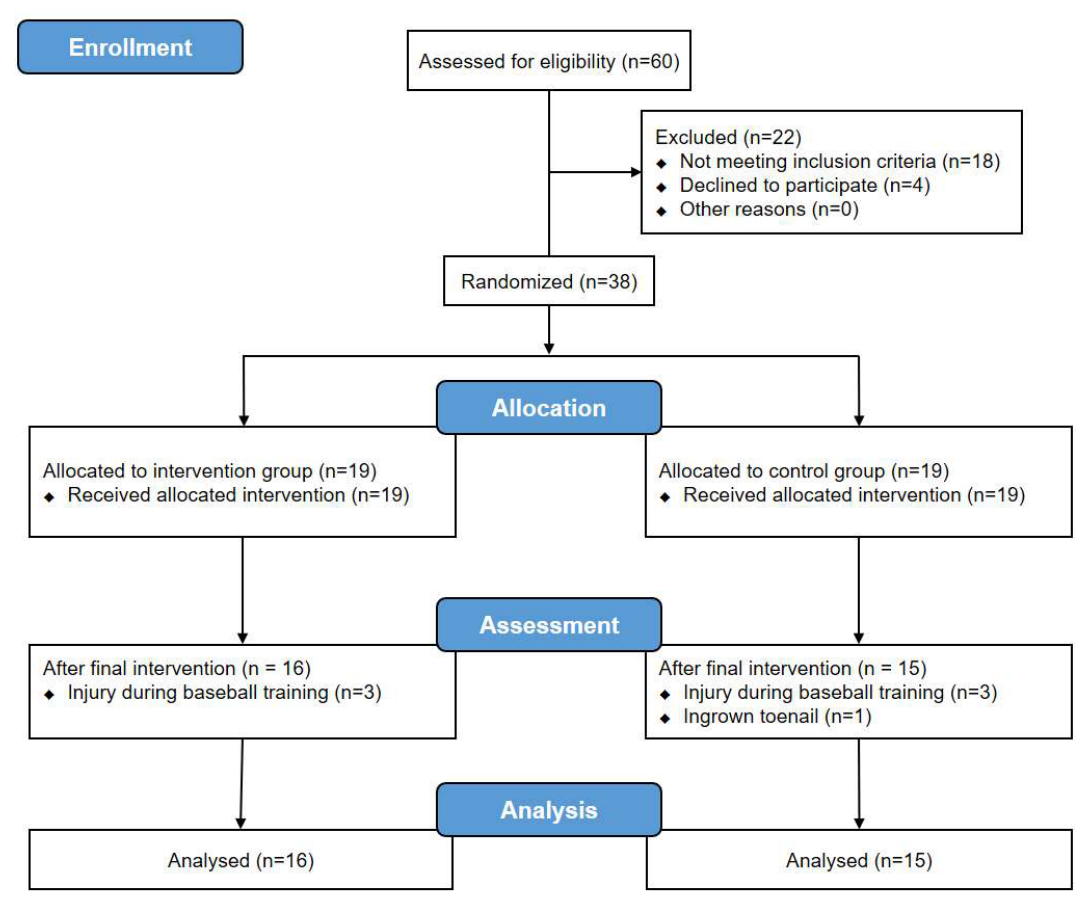
Figure 1. Flow diagram of study participants.